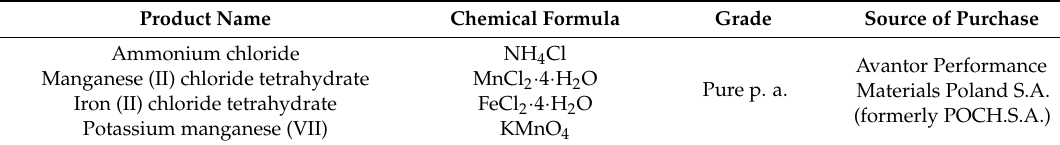
Table 2. List of reagents used in the